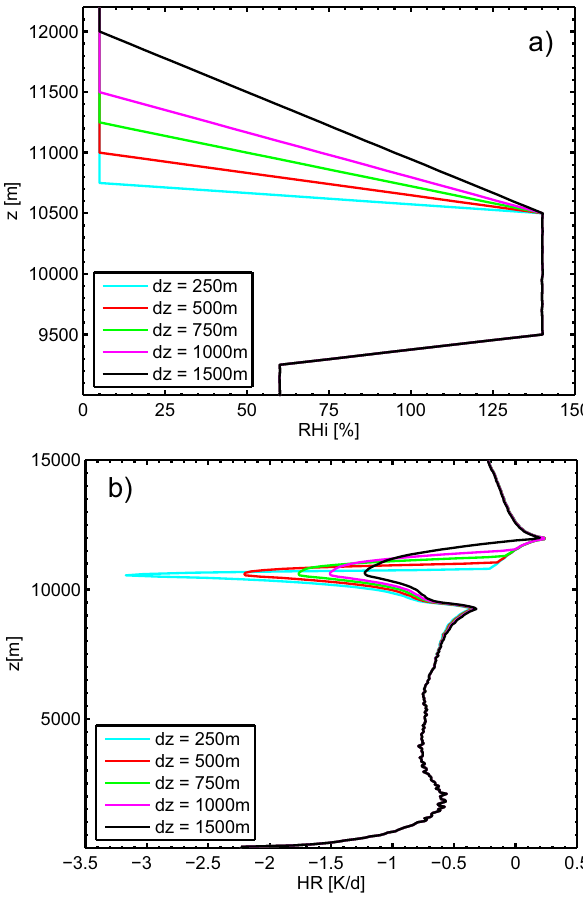
Fig. 11. (a) Vertical RHi profiles of ISSRs using different upper gradients; (b) radiative heating rates for 5 different RHi gradients (initial conditions, see